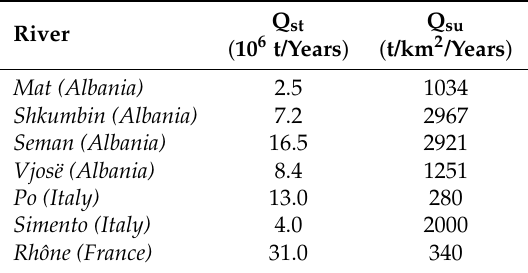
Table 1. Annual total Q st and unit Q su sediment loads of selected Albanian and other European rivers [30,33].